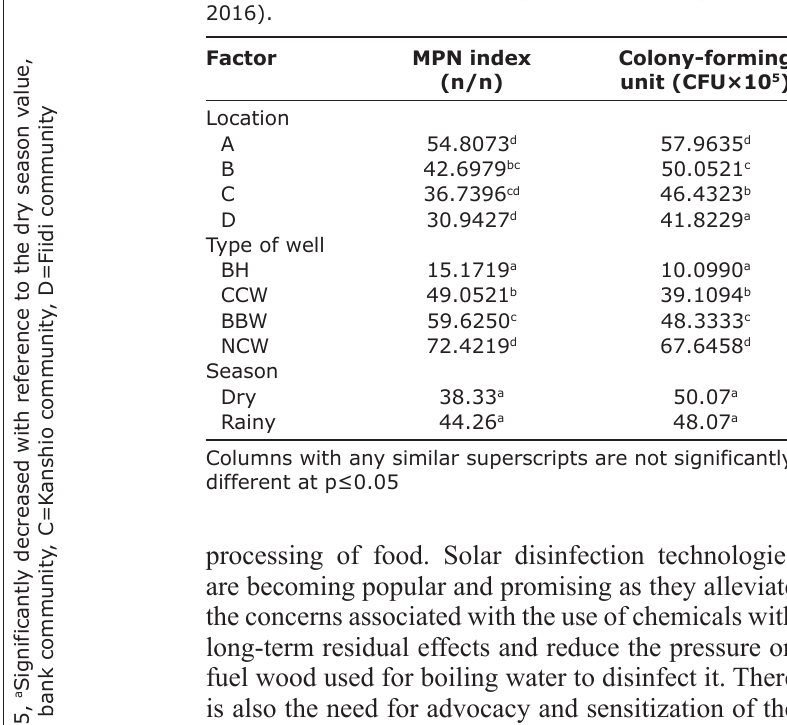
Table-5: Factors affecting the MPN index and colony- forming unit in sampled water from wells and